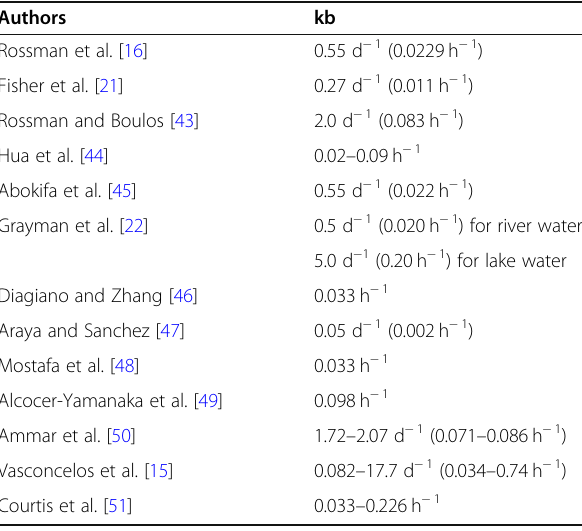
Table 2 kb values obtained by different authors. In this study, a kb = 0.15 h − 1 was obtained, which is higher than most of the values reported in this